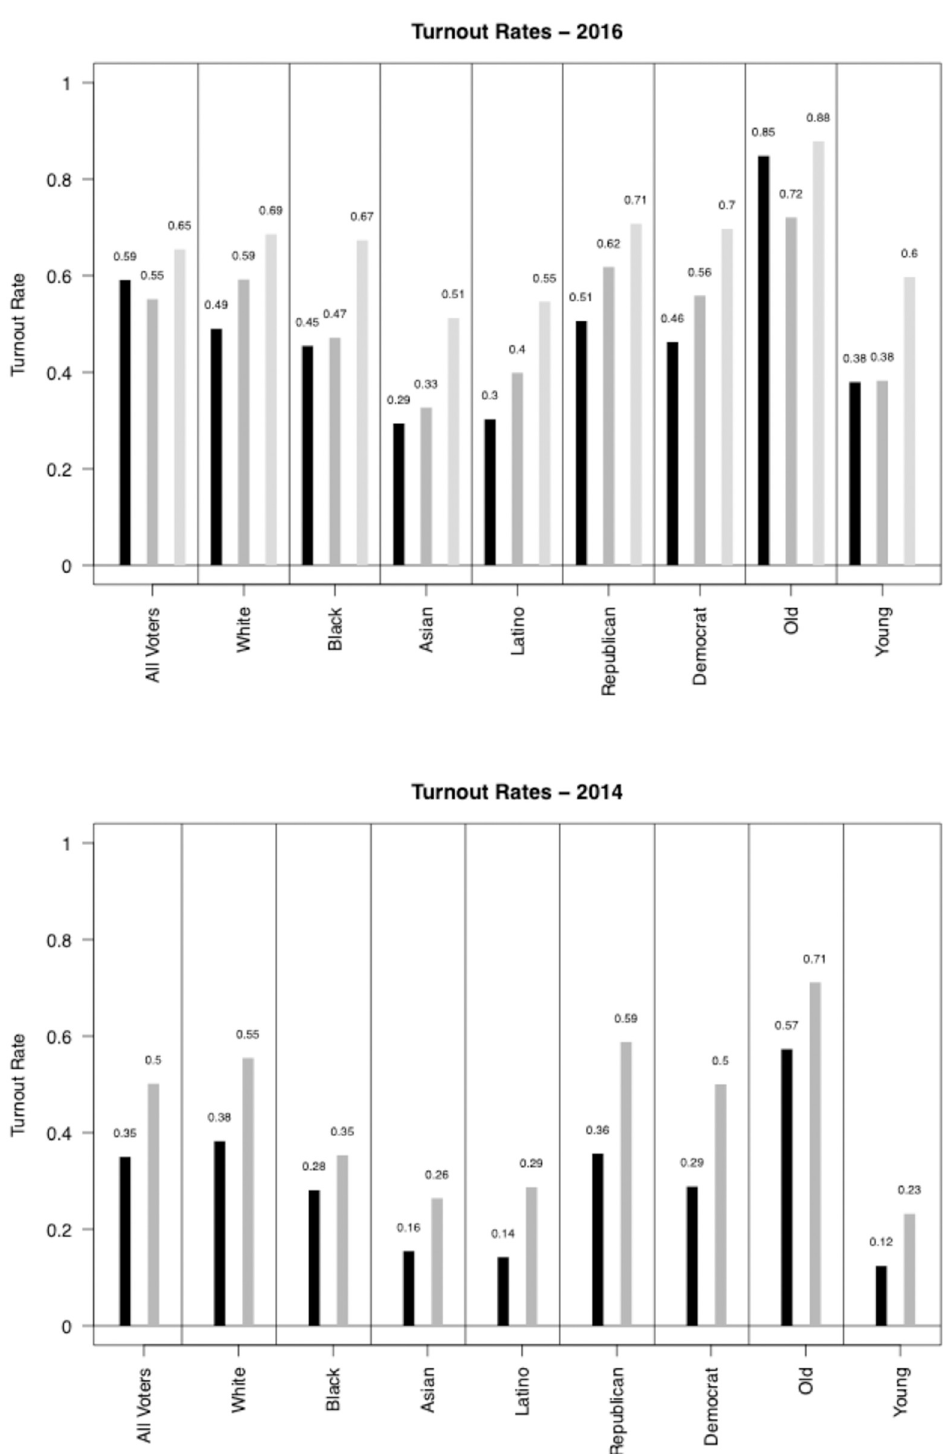
Fig 1. Gaps in validated voter turnout rates by groups using VEP as denominator. Mean levels of voter turnout in 2016 (top) and 2014 (bottom) among individuals in the nationwide voter file (black bars). We use the voting eligible population (VEP) from the US Census for the denominator to determine voting rates. We also report turnout rates using the CCES validated vote (dark grey bars) and the 2016 ANES survey (light grey bars), both of which dramatically over-report turnout in nearly all cases. In all cases “old” is defined as > 60 and “young” is defined as < 30 years old.